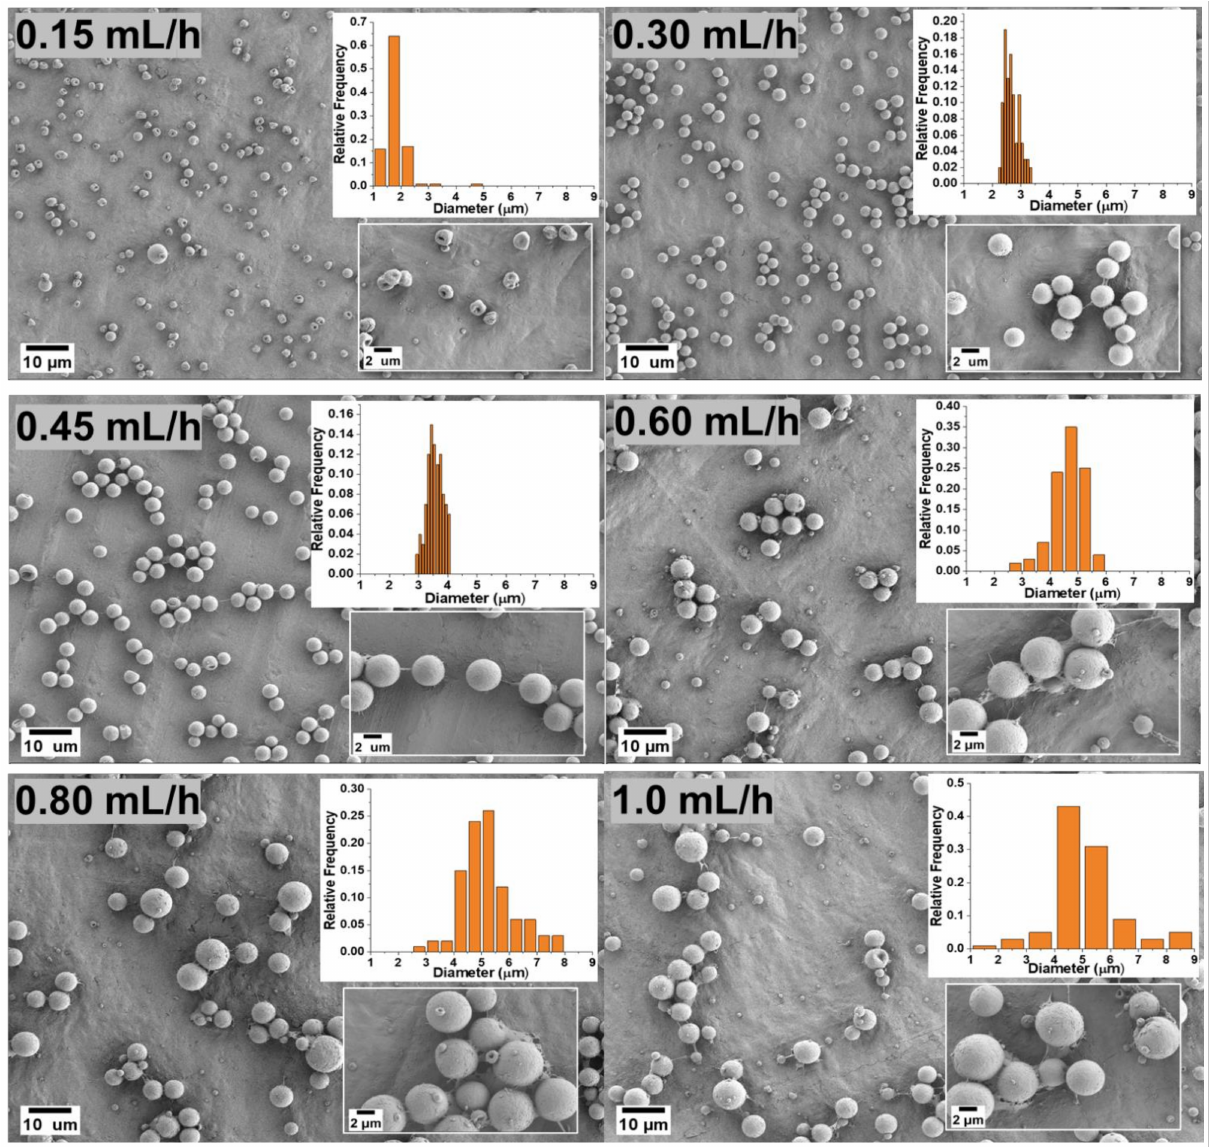
Figure 2. Morphology of the microparticles for the samples obtained with a 5 wt.% PVDF in DMF/ACE 60:40 ( v / v ) polymer solution at different flow